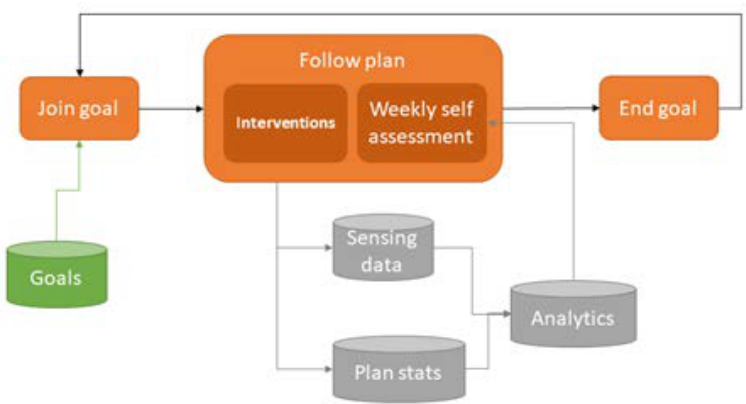
Figure 4. Older adult perspective of the virtual coaching ecosystem.